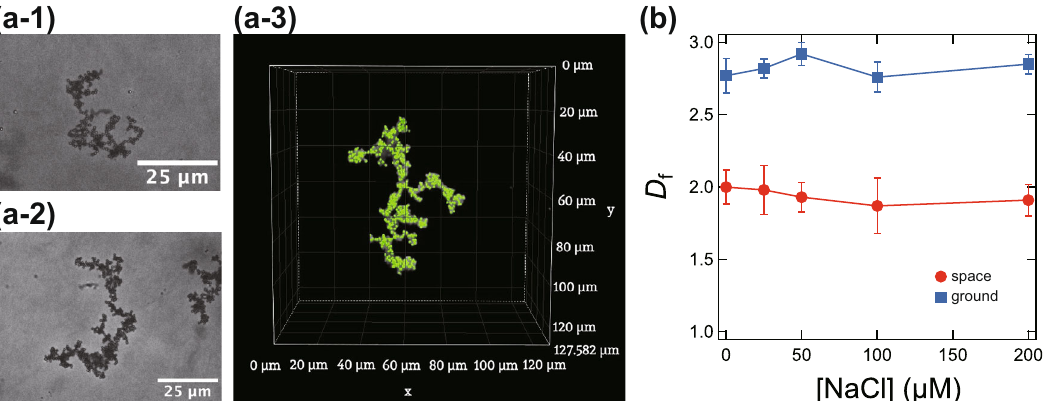
Fig. 8 Microscopic images of aggregates formed in the titania-based space experimental samples. ( a-1 ), ( a-2 ) inverted microscope images, and ( a-3 ) the confocal laser microscope image. b Fractal dimension D f of the aggregates obtained for samples having various [NaCl] values. Red and blue symbols represent results for space and ground control samples, respectively.